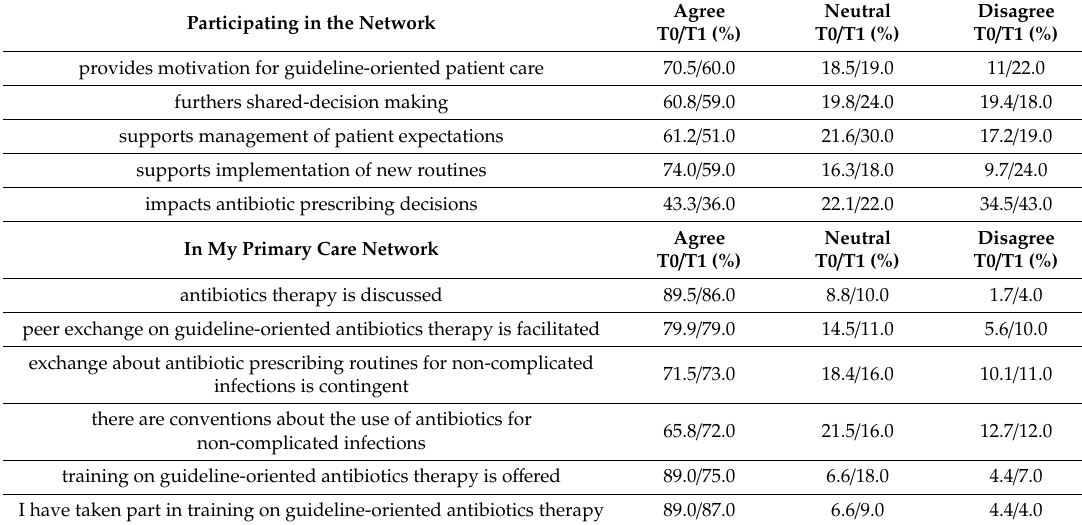
Table 5. Physician perspective on network participation (T0 n = 229; T1 n =